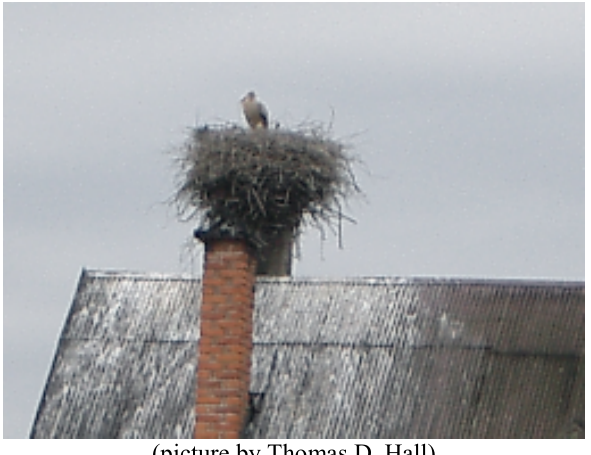
(picture by Thomas D.